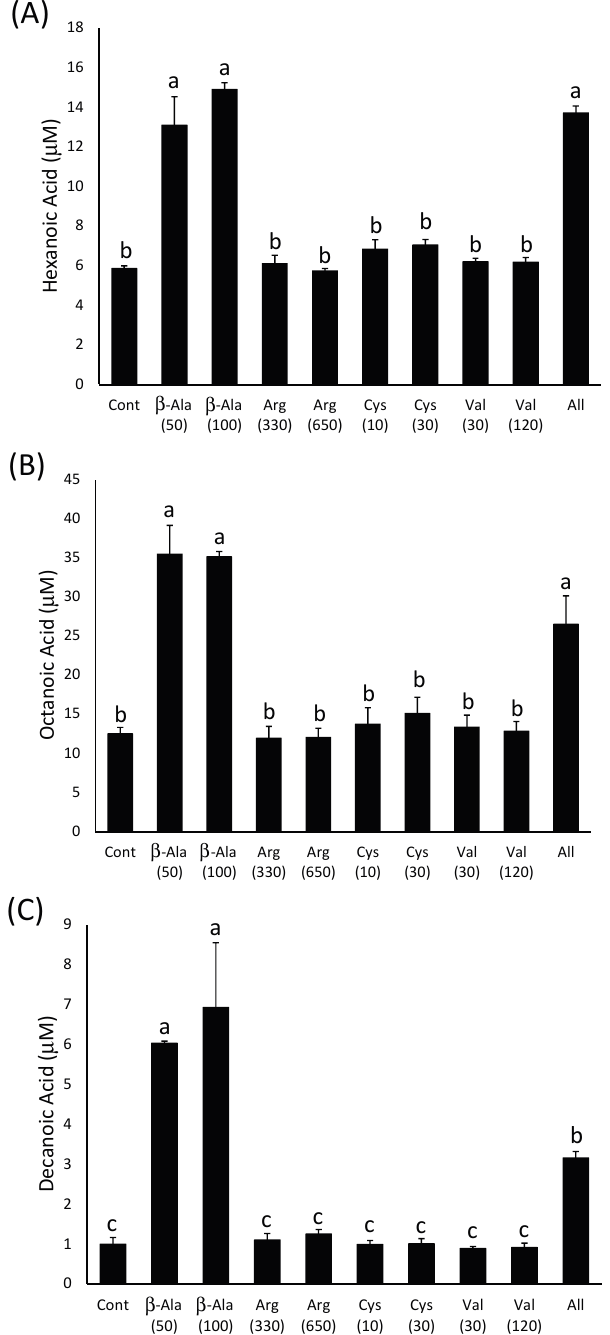
Figure 5. The concentration of ( A ) hexanoic acid, ( B ) octanoic acid and ( C ) decanoic acid in model wines produced after the addition of amino acids as indicated on the x-axis. The number in brackets represents the concentration added in mg·L − 1 . Histograms represent the mean values (n = 3) and error bars show standard errors. Different letters (e.g., a, b, c) denote significant differences between treatments at p < 0.05 using ANOVA followed by Tukey’s post hoc